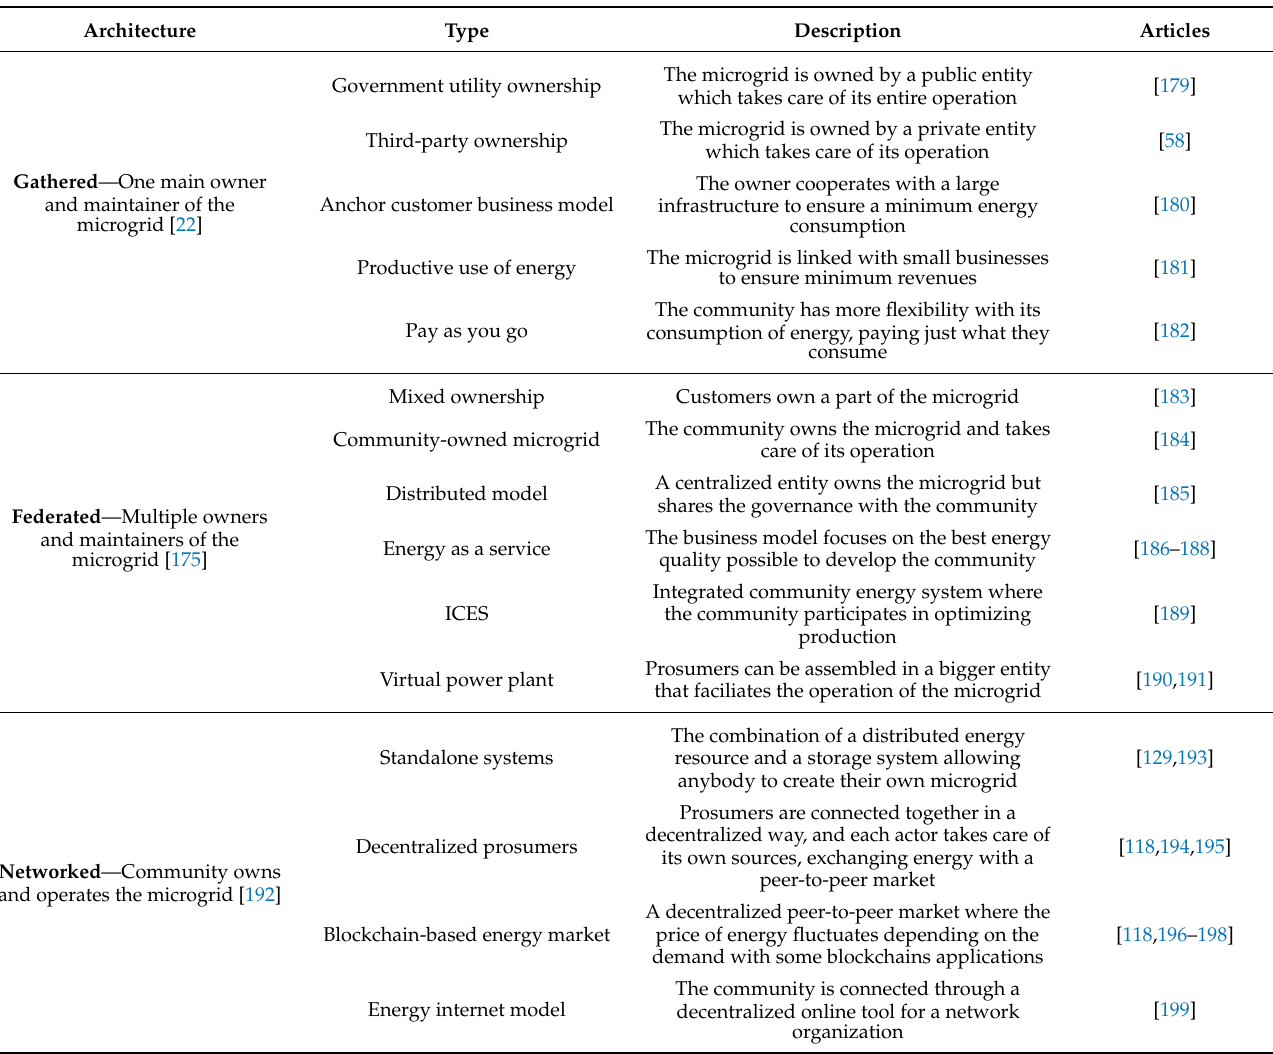
Figure 9. Representation of the different financial architectures. Table 8. Classification of microgrid business model